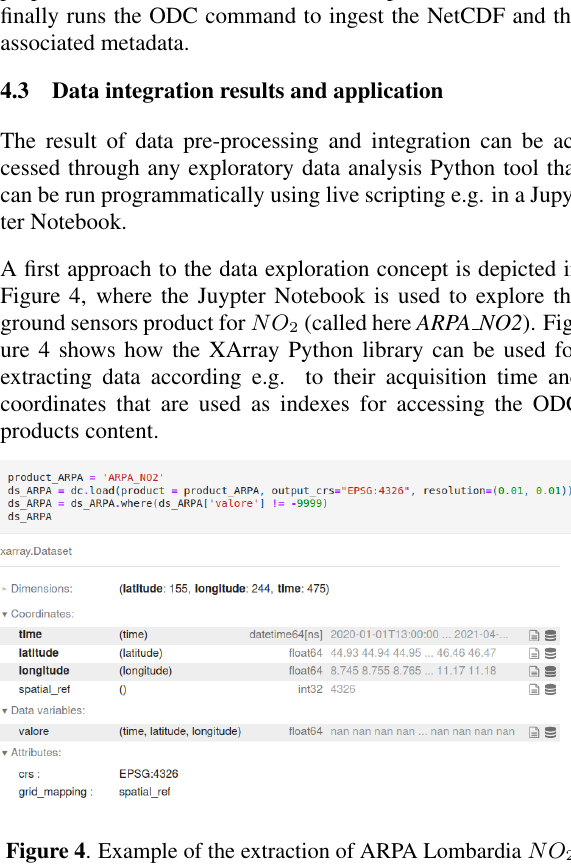
Figure 4 . Example of the extraction of ARPA Lombardia NO